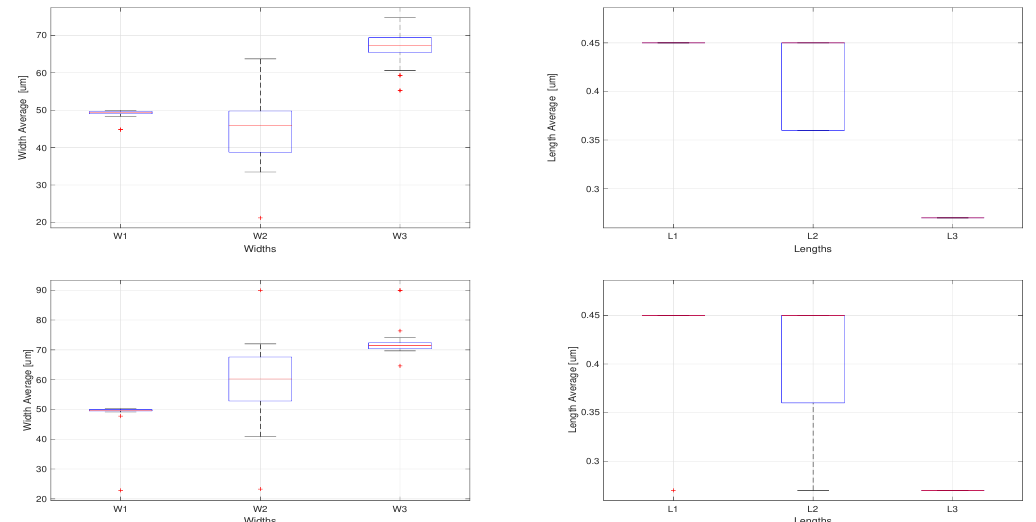
Figure 11. Box plots of the widths and lengths of the transistors of the Miller OTA applying PSO (in the first row) and MOL (in the second row).